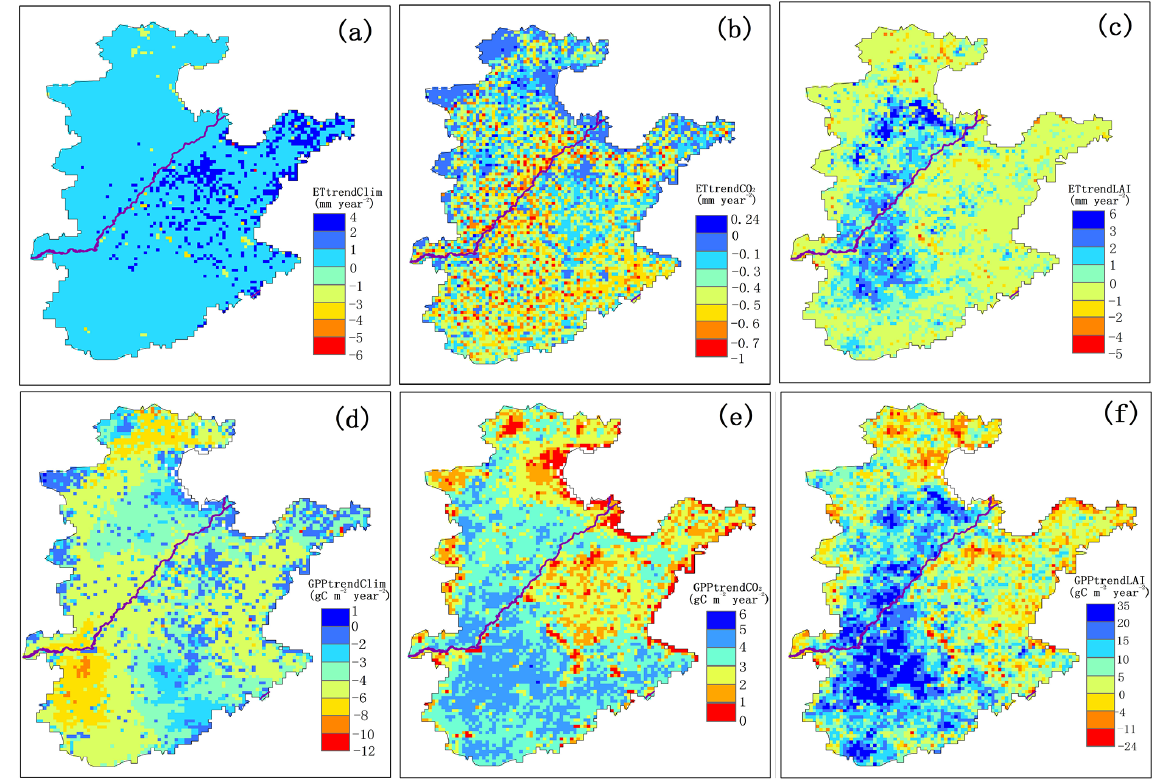
Figure 11. Contributions of climate changes, CO 2 enrichment, and management to ET (a, b, c) and GPP (d, e, f) , respectively ( a and d are for climate, b and e for CO 2 , and c and f for management).